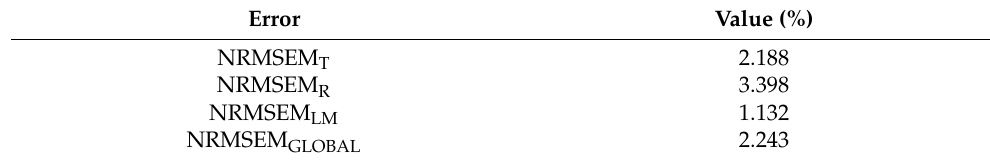
Table 4. NRMSE of M mean (results expressed in